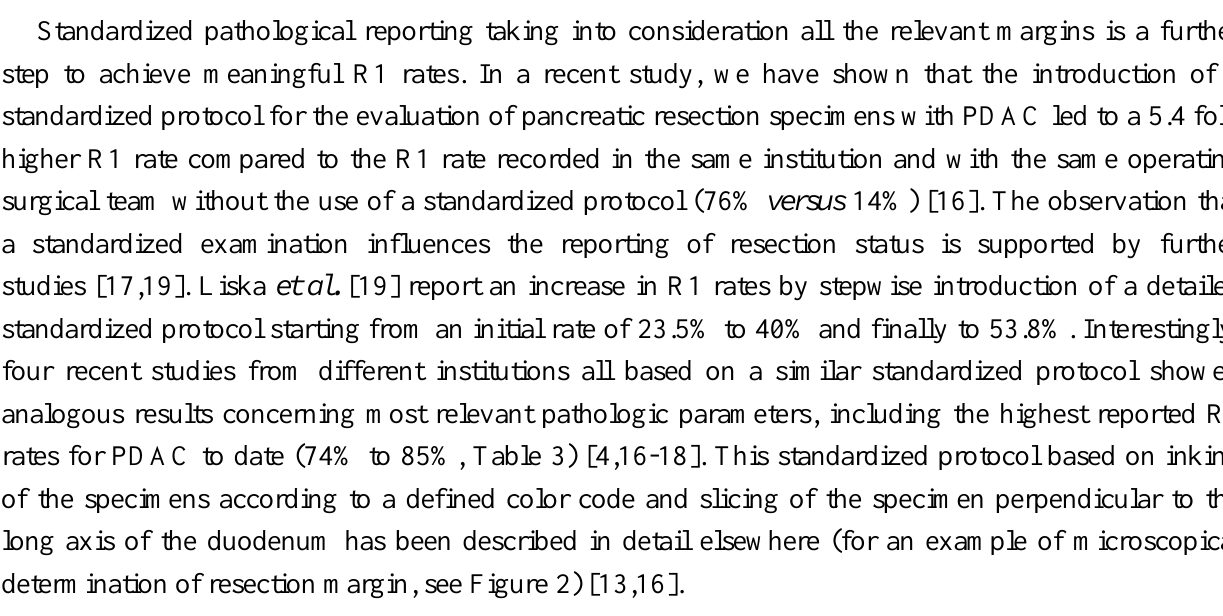
Figure 2. Pancreatoduodenectomy specimen with tumor infiltration (R1): Direct invasion of tumor cells within 1 mm of the medial margin